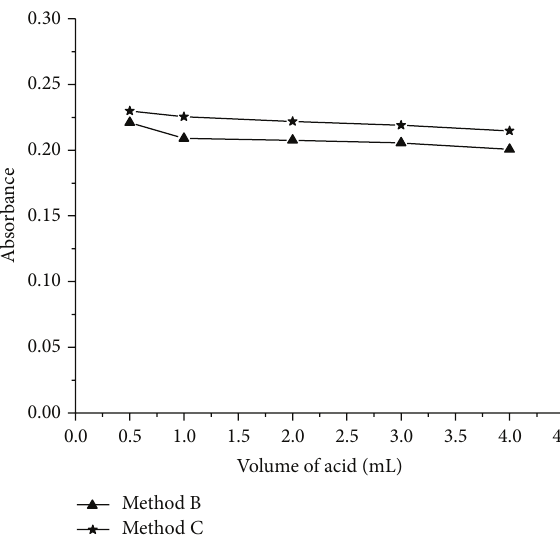
Figure 2: Absorption spectra: 6.0 𝜇 gmL −1 STS, tri-iodate (method B); 2.0 𝜇 g mL −1 STS, starch-iodide complex (method C).